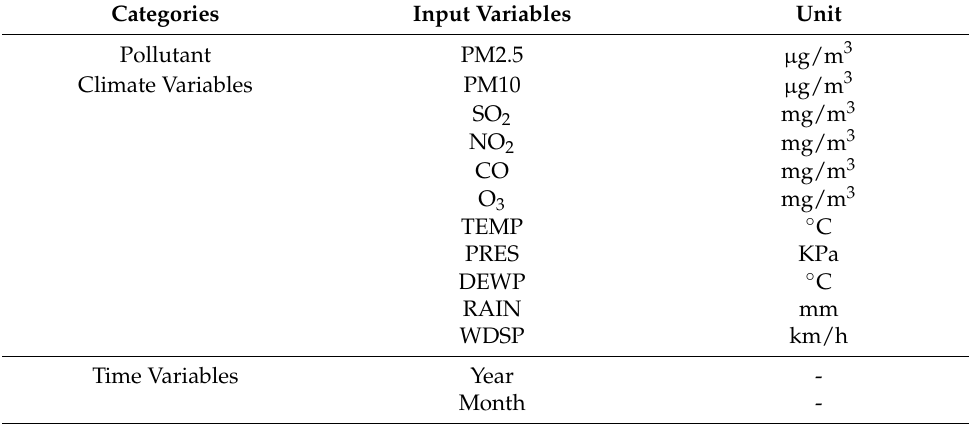
Table 1. Variables contained in the